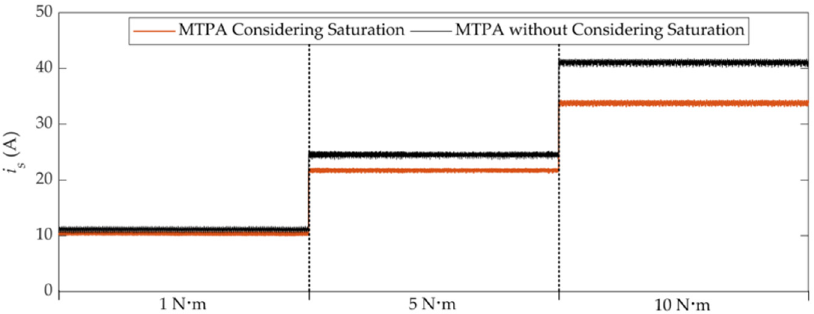
Figure 14. Amplitudes of the stator current i s under two MTPA modes (with and without saturation characteristics) with different loads.